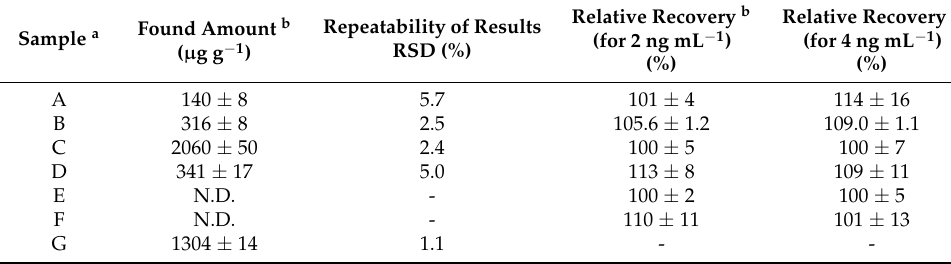
Table 3. Application of the method to the analysis of commercial samples. Sample